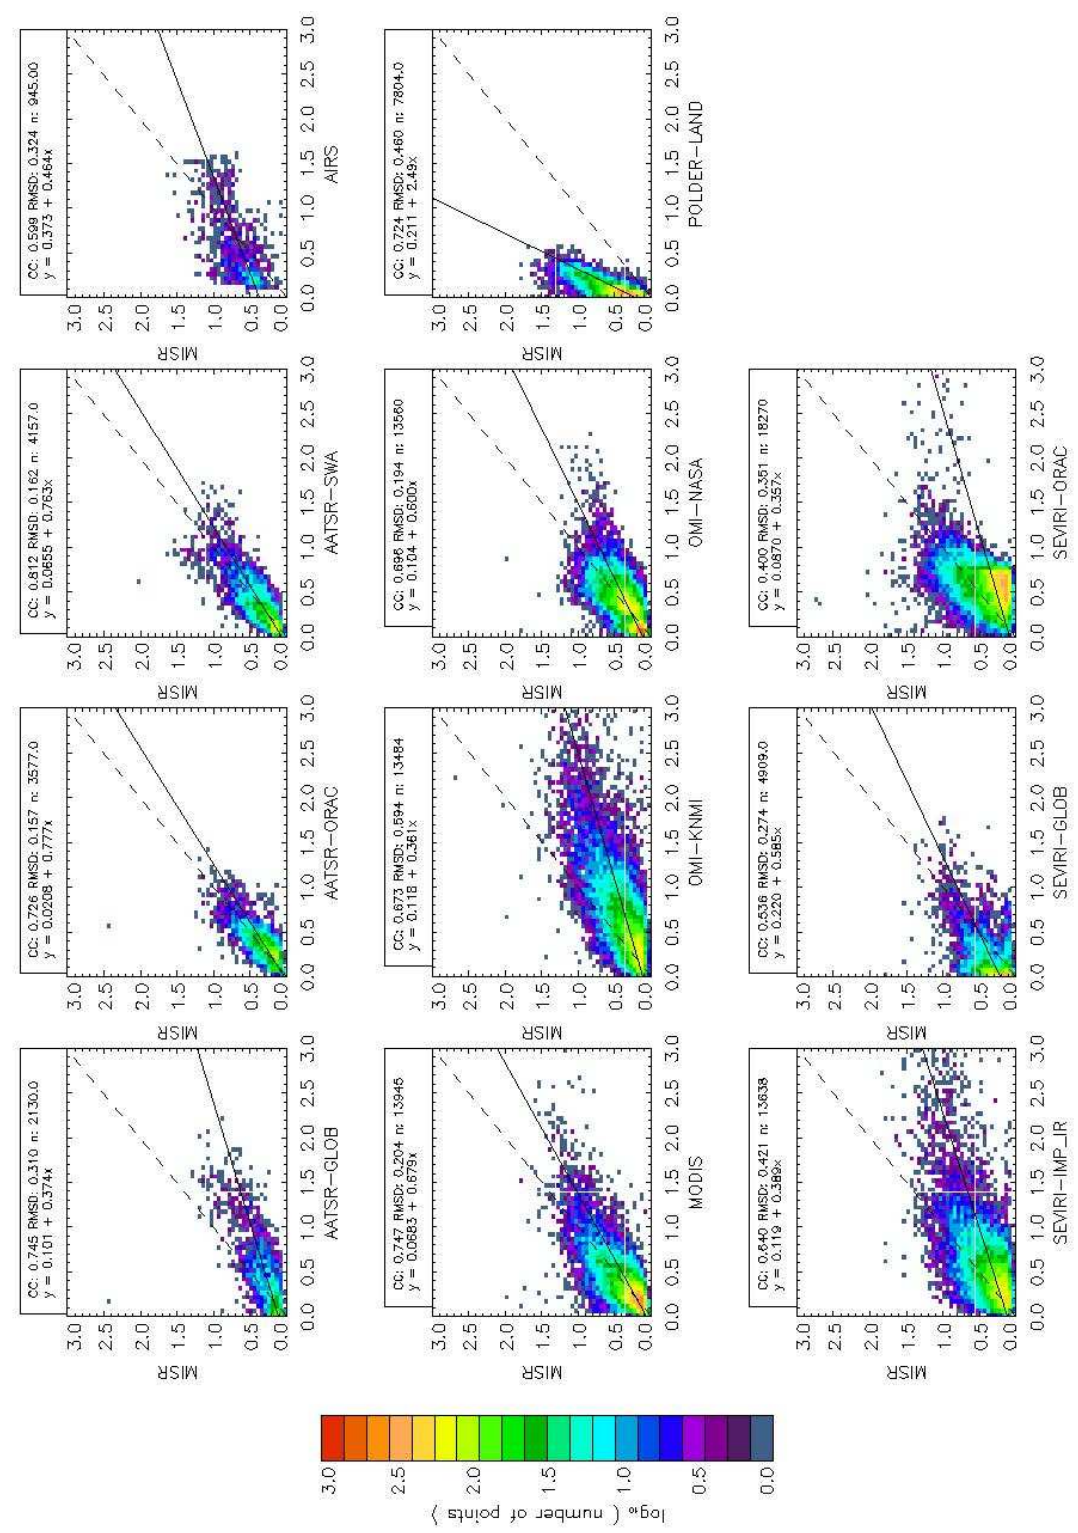
Fig. 6. Example of comparison over land, MISR vs. other datasets. In every scatter plot there is a caption: the first line indicates the correlation coefficient (CC), the root mean square differences (RMSD) and the number of coincidences (n); the second line presents the best linear fit.